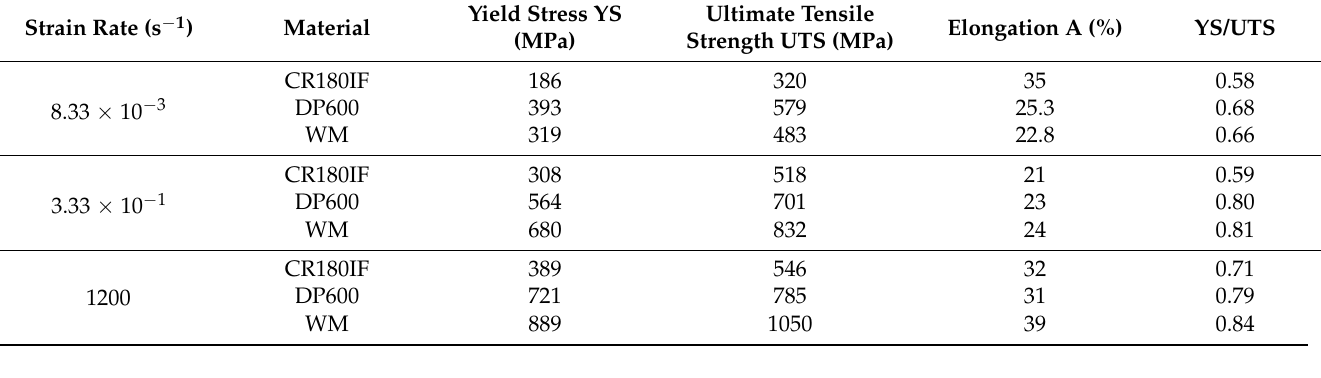
Table 4. Mechanical properties of investigates steels CR180IF, DP600, and welded material (WM).